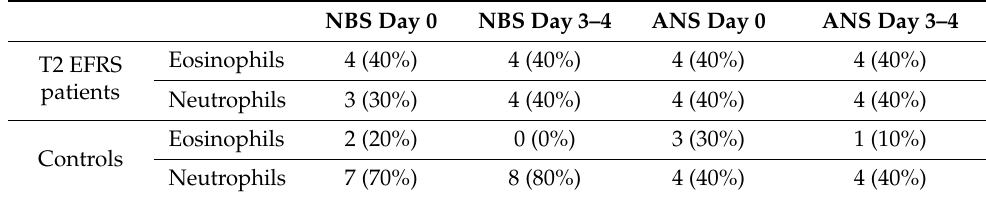
Table 3. Eosinophil and neutrophil positivity of T2 EFRS patients and controls, based on nasal blown secretions (NBS) and aspiration of nasal secretions (ANS) at two different time